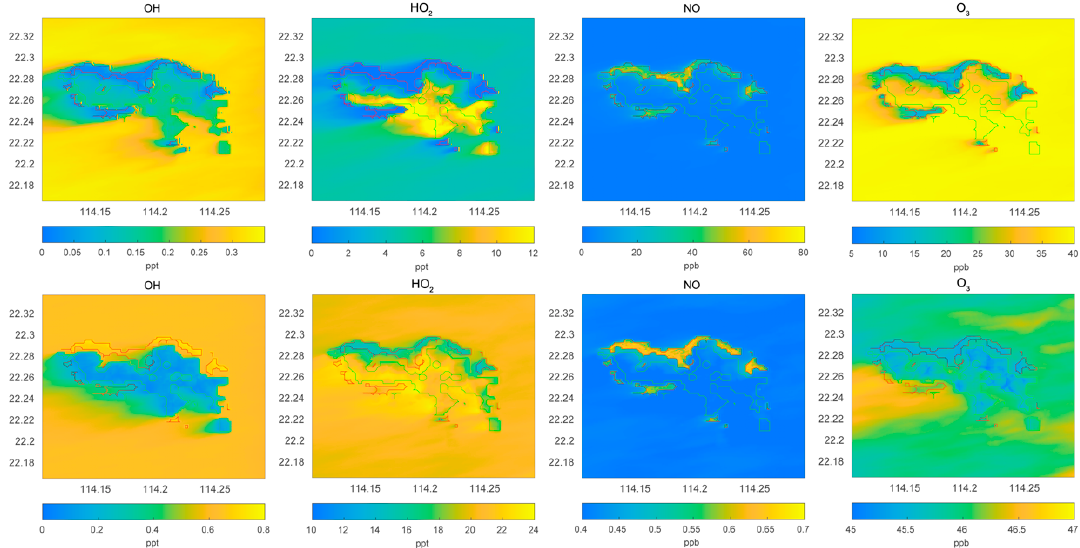
Figure 2. Horizontal distribution of the surface mixing ratio of the hydroxyl radical OH (pptv), the peroxy radical HO 2 (pptv), and the ozone molecule (ppbv). Upper panel: POLLUTED conditions; lower panel: CLEAN conditions.